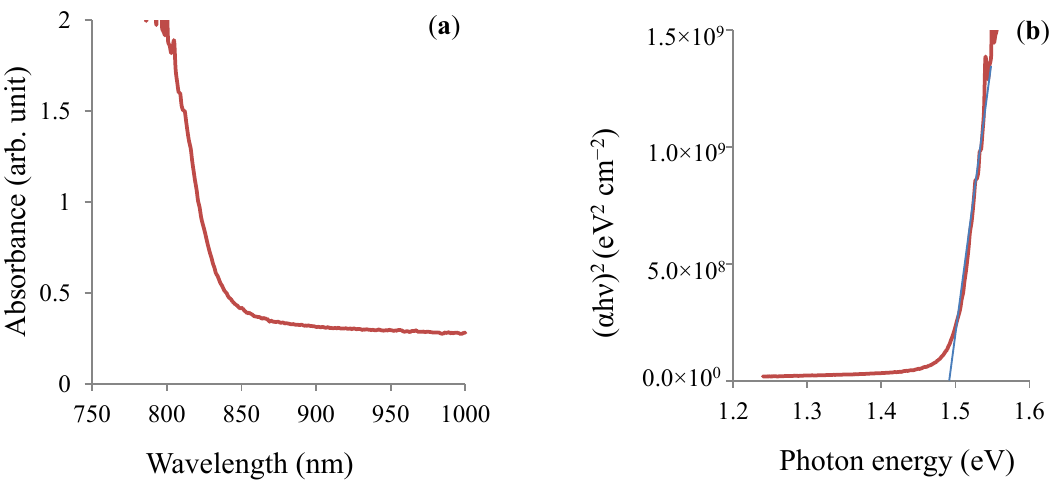
Figure 11. ( a ) Absorbance vs. wavelength and ( b ) the Tauc plot, for electroplated CdTe layer on glass/FTO